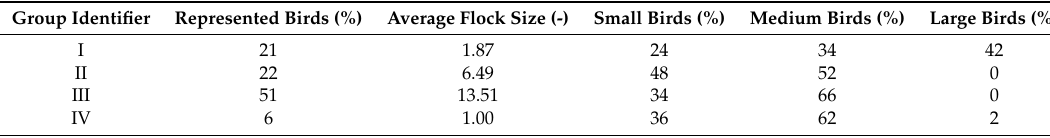
Table 4. Determined flock size groups within the range of the weather radar (200 m–1000 m) during daytime. Average flock sizes for groups I–III were calculated by including all birds in the respective species. To separate individually flying birds, they were subtracted from the birds represented in group I–III and categorized into group